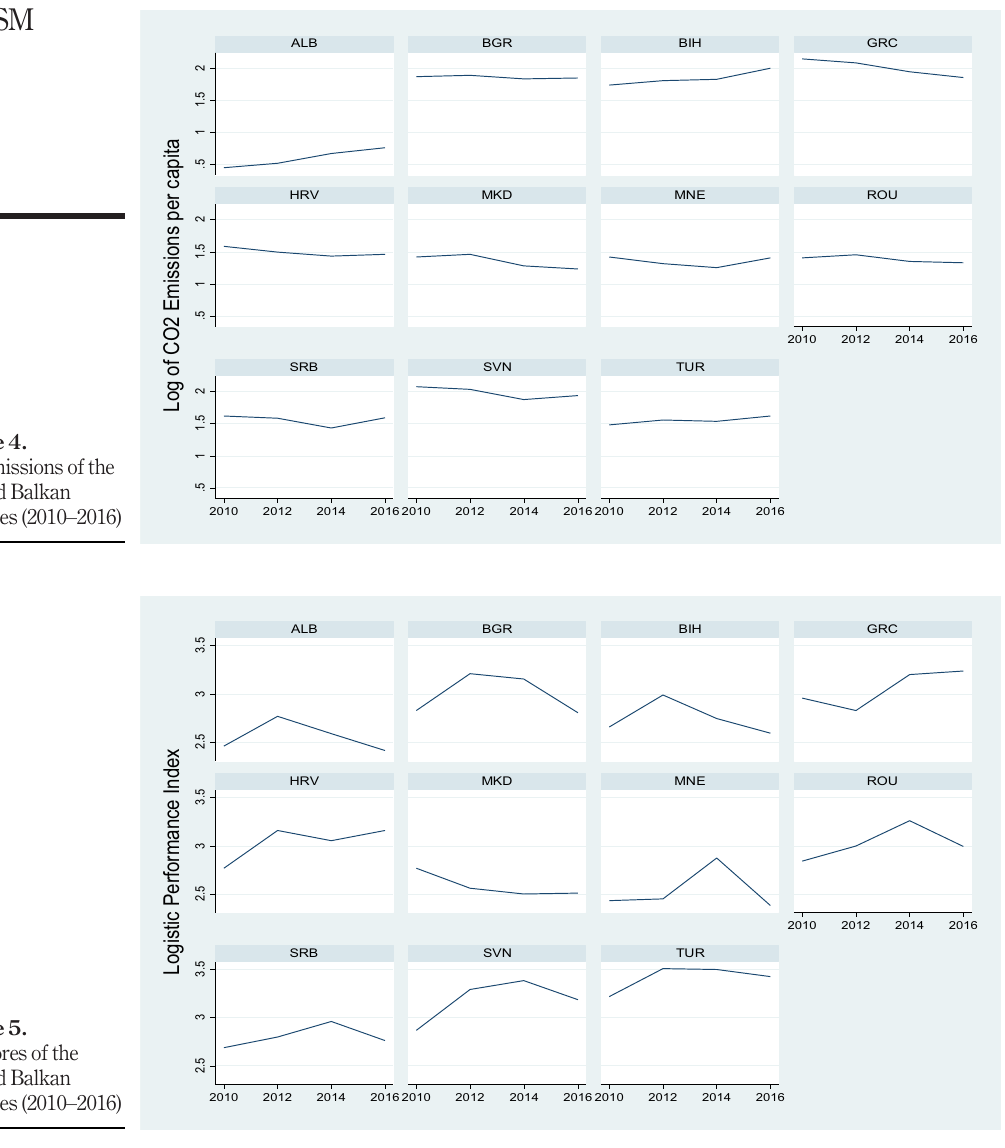
Croatia, Greece, North Macedonia, Romania and Slovenia demonstrated a decreasing trend for the sampled years. When considering LPI scores, Turkey has the highest score (LPI = 3.42), and 2016 Montenegro has the lowest score (LPI = 2.38) in 2016. As can be seen in Figure 5, the 2016 trend of LPI scores varies from country to country. Croatia, Greece, Romania, Serbia,